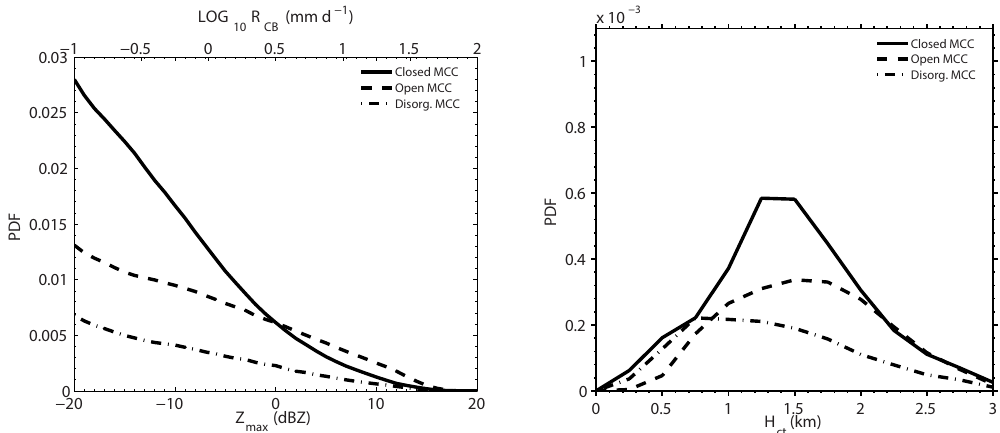
Figure 10. PDFs of column maximum radar reflectivity Z max (left) and cloud top height H ct (right) for low clouds with closed (solid), open (dashed) and cellular but disorganized (dash-dotted) MCC types. All PDFs are based on global data. The median cloud top height is 1460m for closed MCC, 1570m for open MCC and 1300m for cellular but disorganized